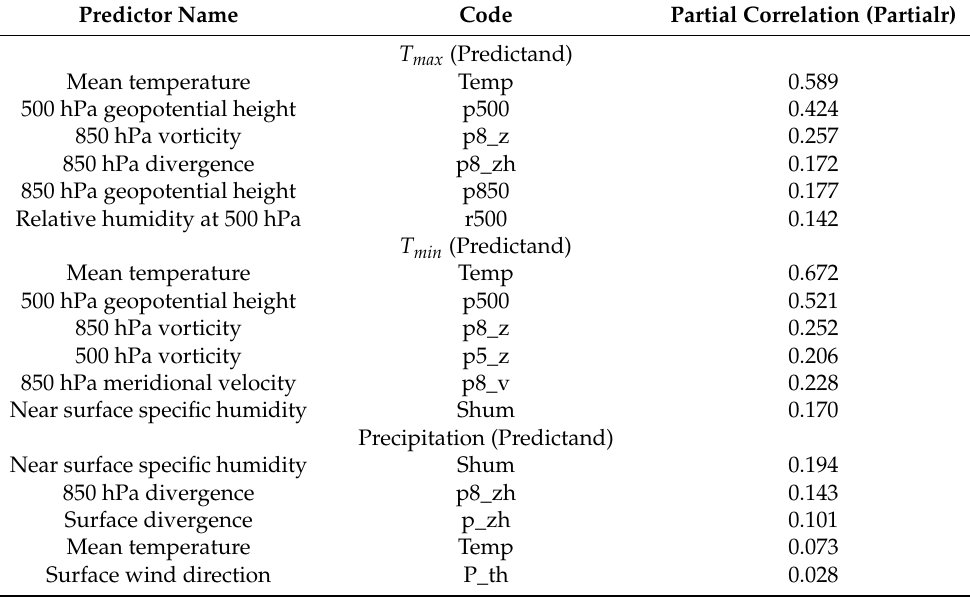
Table 1. Selected predictors for maximum and minimum temperature and